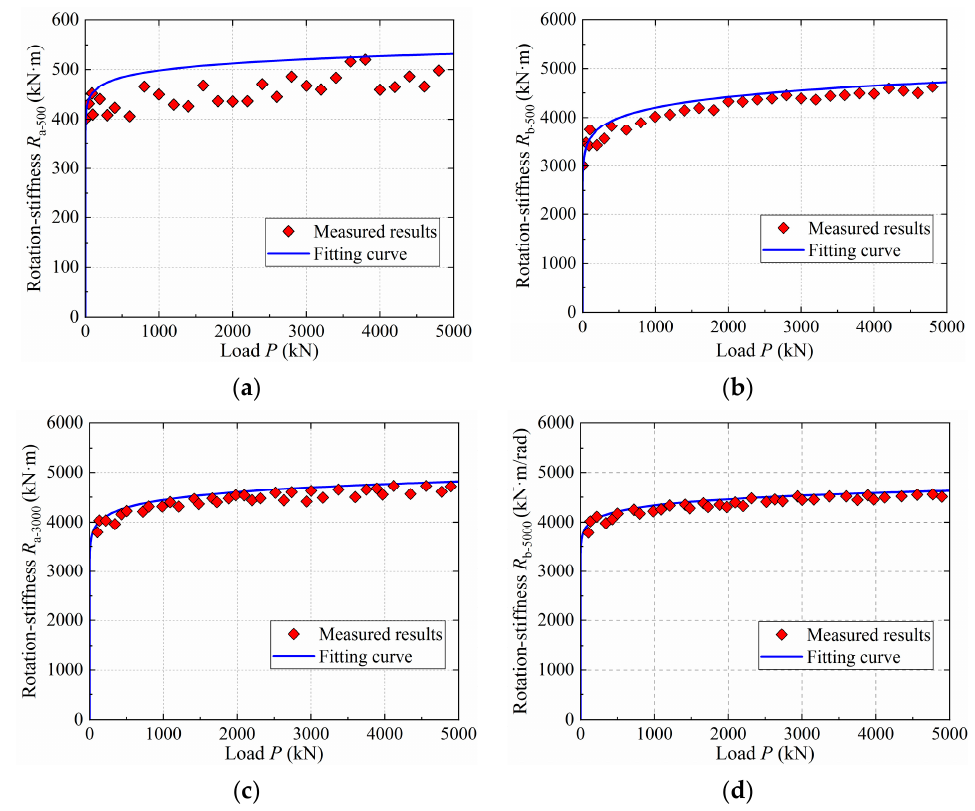
Figure 5. The load-rotation stiffness ( P - R ) curves: ( a ) The bottom of 500 t; ( b ) The top of 500 t; ( c ) The bottom of 3000 t; ( d ) The top of 3000 t.